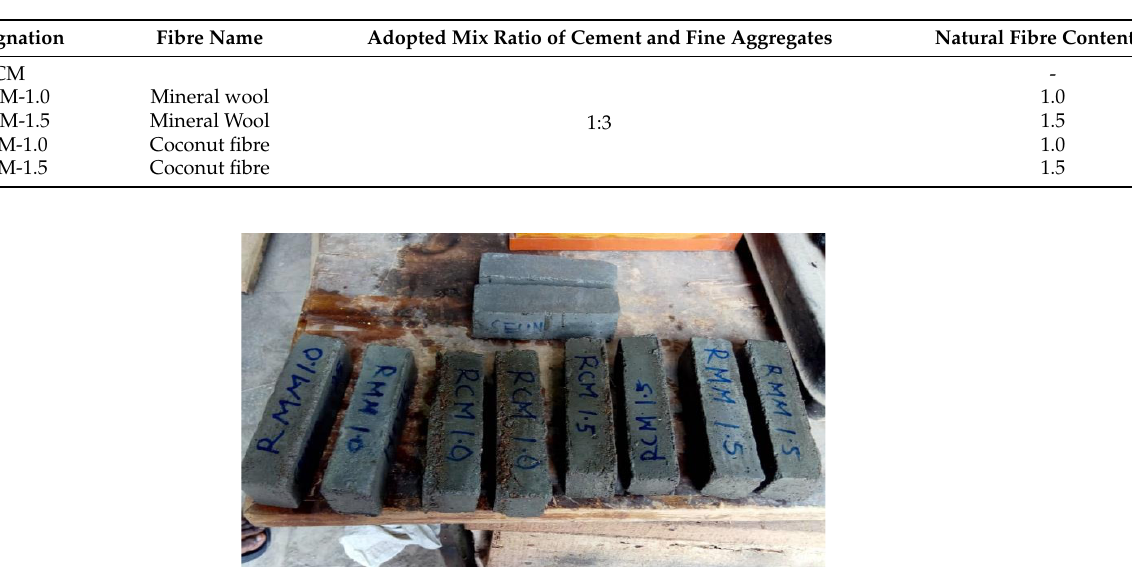
Figure 2. Mix configurations: ( A ) Coconut fibres + fine aggregate + cement; ( B ) Mineral wool fibres Table 2. Sample configurations. + fine aggregate + cement.